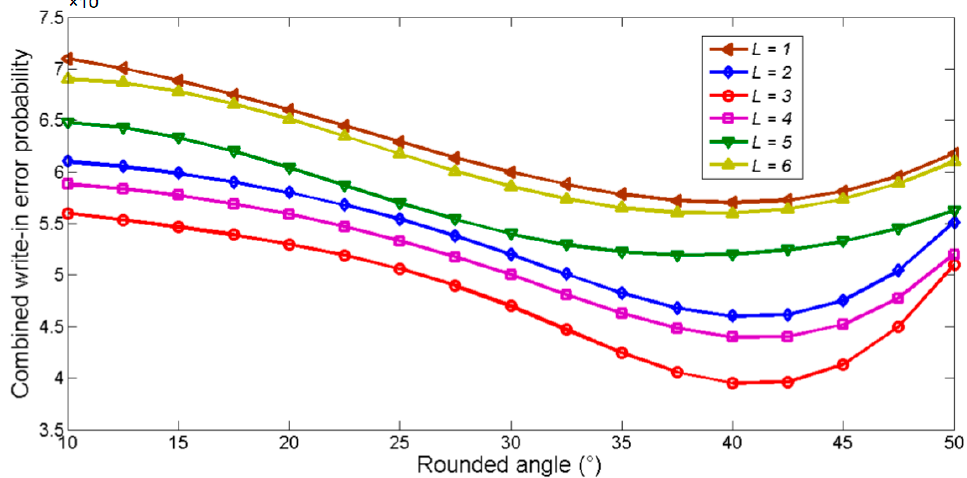
Figure 6. Combined write-in error rate with different rounded angle ( θ ) and corner length ( L ).